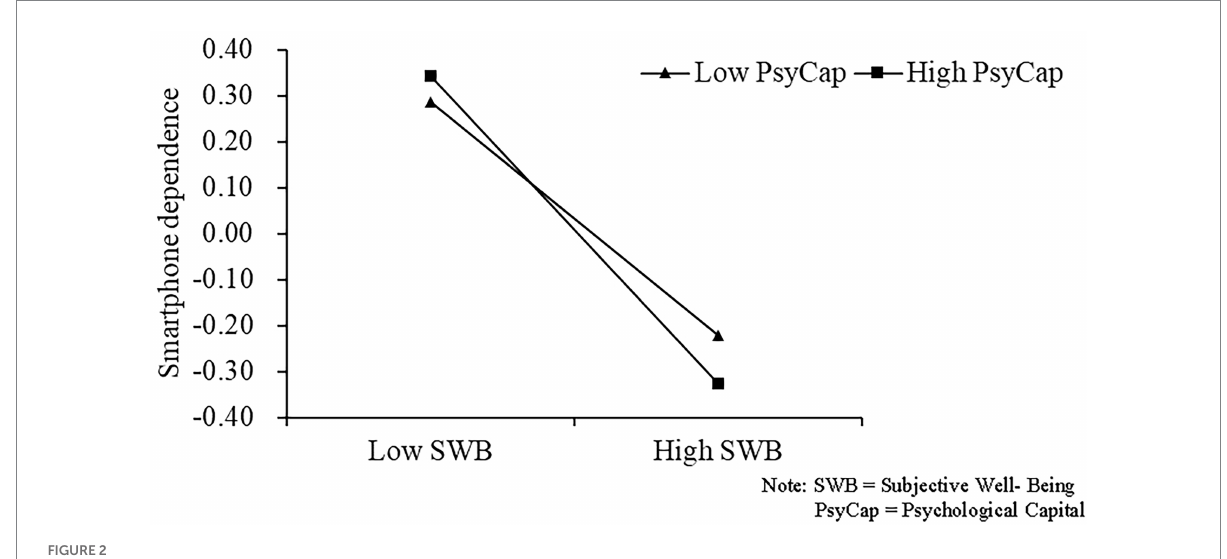
FIGURE 2 Simple slope